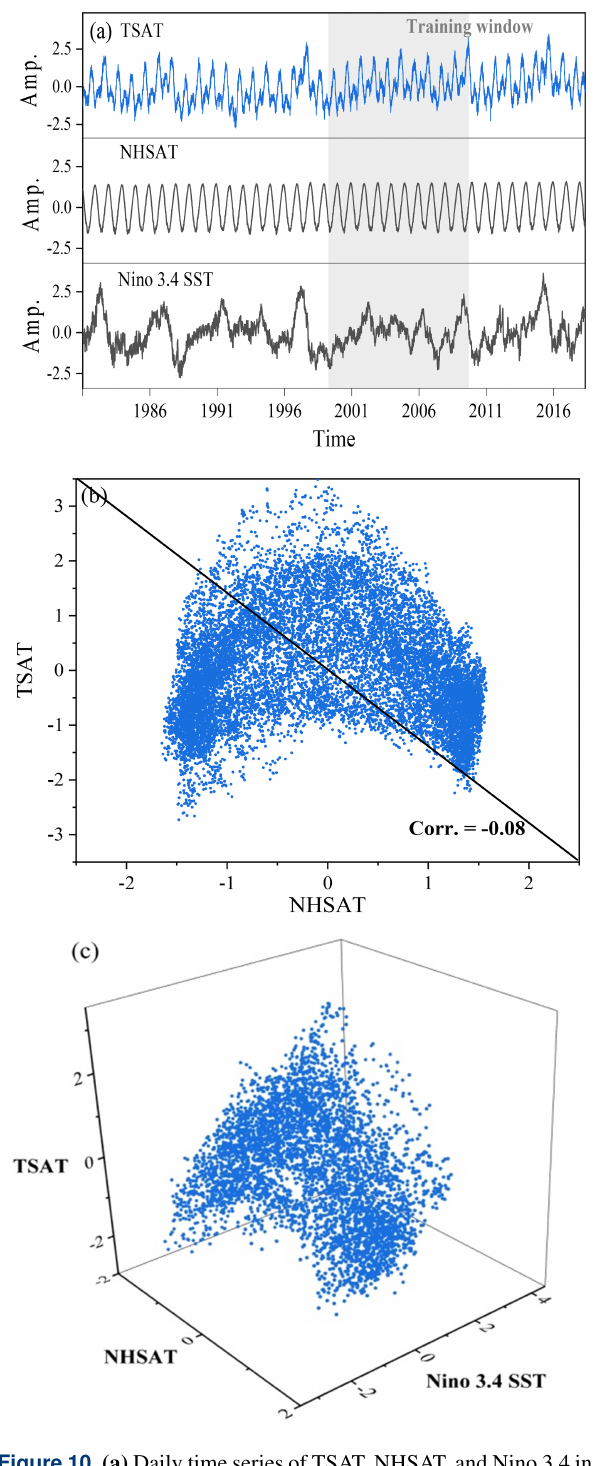
Figure 10. (a) Daily time series of TSAT, NHSAT, and Nino 3.4 in- dex. (b) Scatter plot of normalized NHSAT and normalized TSAT. (c) Three-dimensional scatter plot of normalized NHSAT, normal- ized TSAT, and normalized Nino 3.4 sea surface